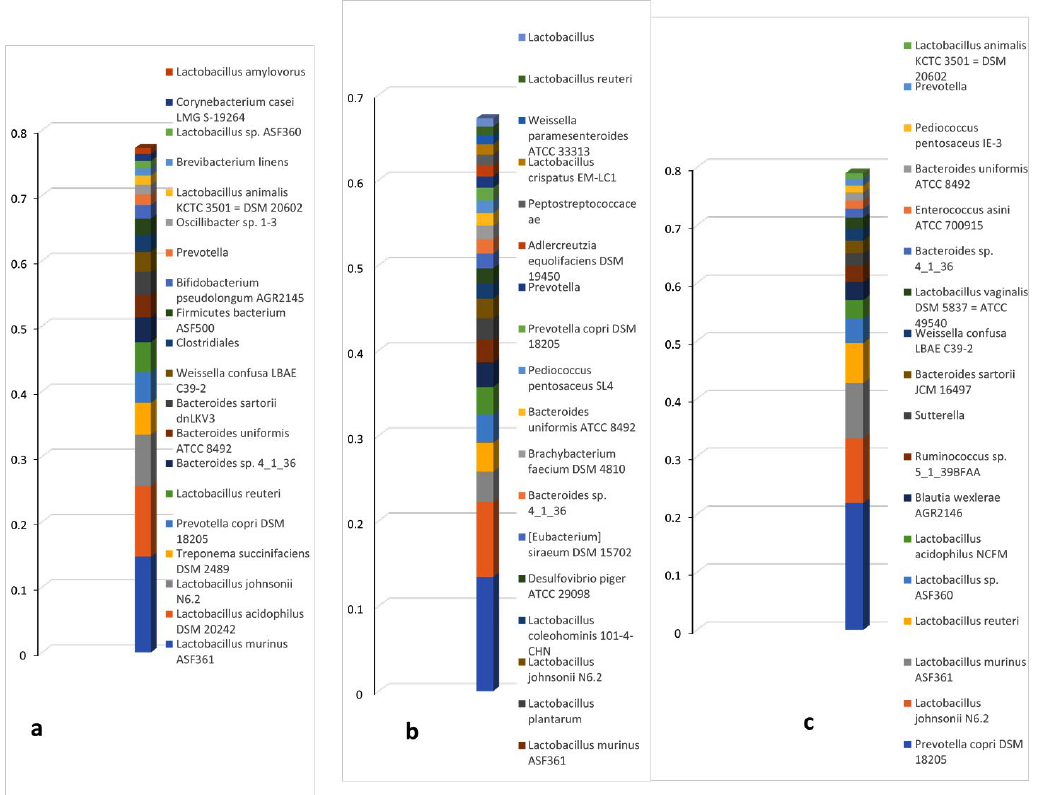
Fig. 3. Dominant bacterial species in the colonic flora of (a) normal rat, (b) untreated diabetic rat and (c) rat treated with 400 mg/Kg bw G. latifolium . Note depletion of the normally dominant species in diabetic rat and proliferation of other species (dysbiosis). Note also, restoration and improvement with G. latifolium